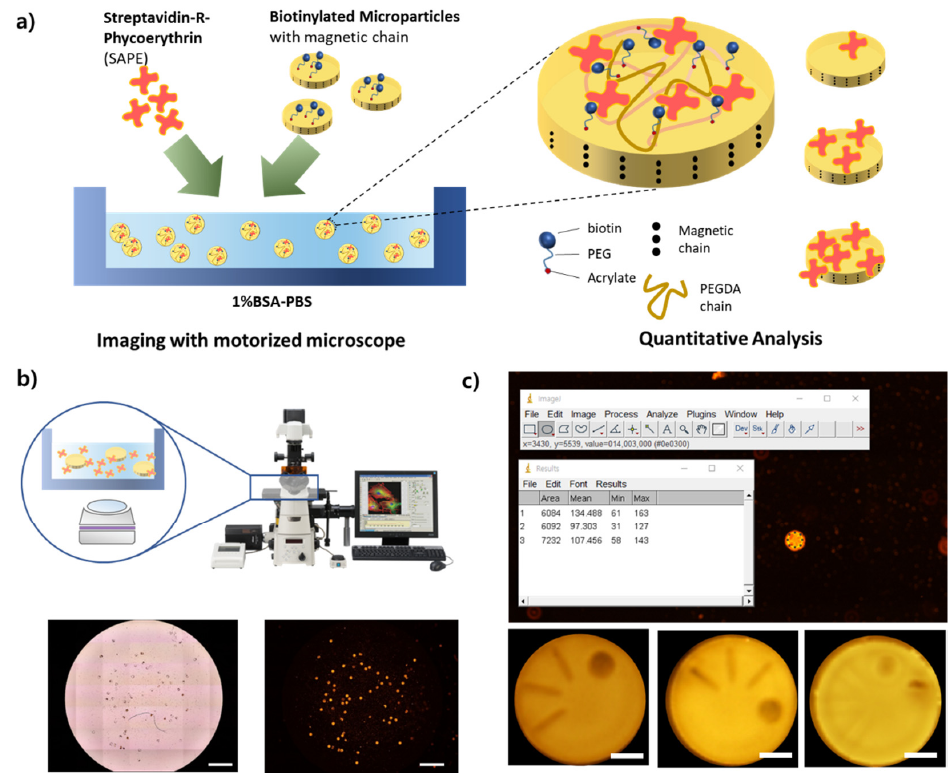
Figure 3. The design of a binding assay for validation and its analysis process. ( a ) A schematic of the validation method using binding between the biotinylated microparticle and streptavidin with fluorophore as a proof-of-concept. ( b ) The process of data acquisition using fluorescence microscopy with a motorized stage. Scale bar, 1 mm. ( c ) Quantitative analysis based on fluorescence image acquired after large-scale imaging. Scale bar, 25 µm.